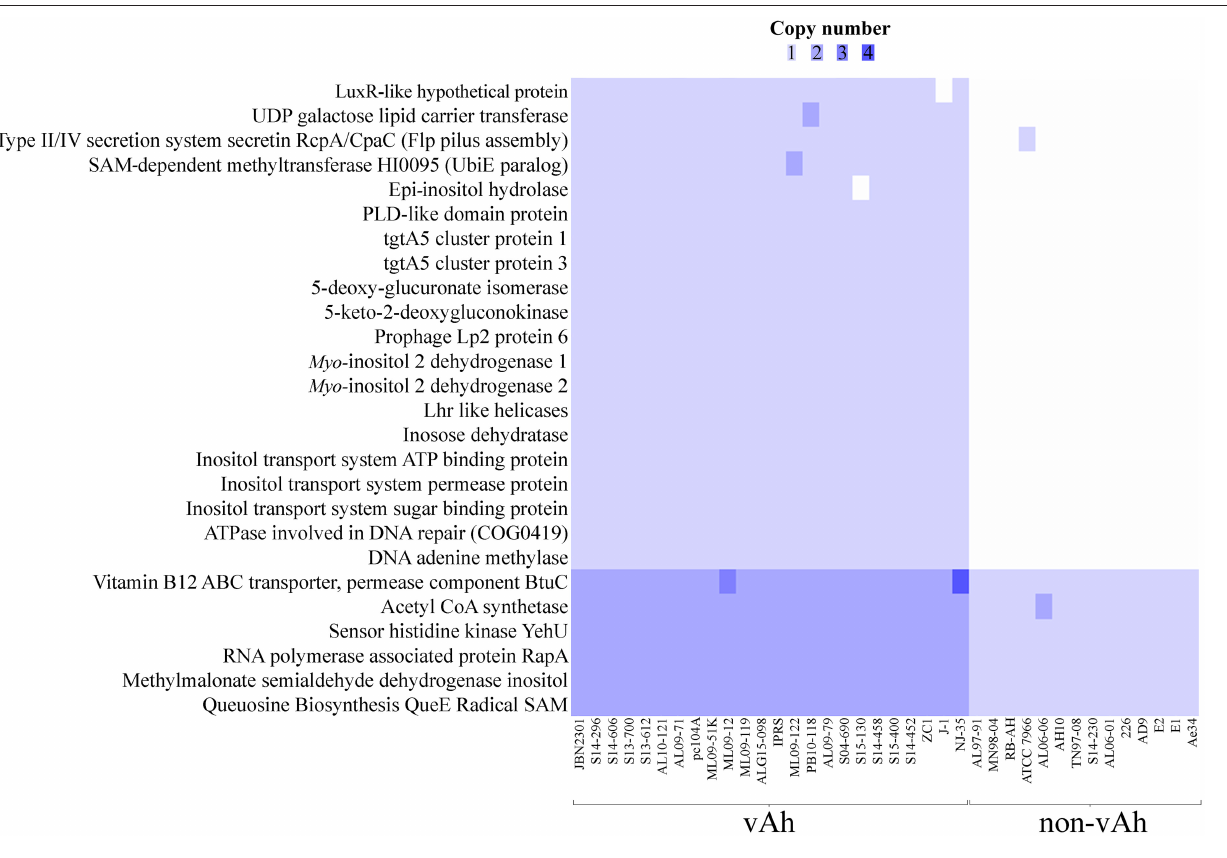
FIGURE 6 | Comparative whole genome predicted gene-based analysis of all confirmed vAh ( n = 26) and non-vAh isolates ( n = 15).